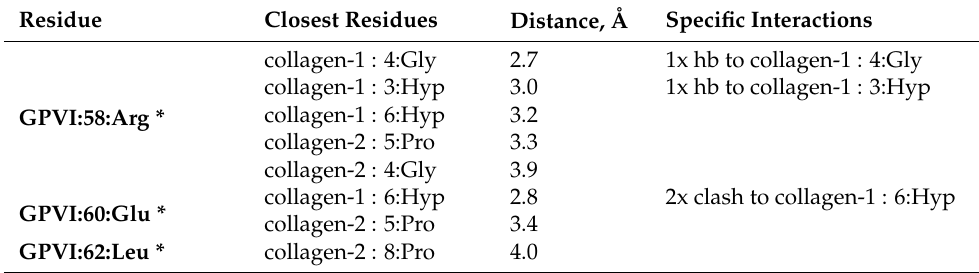
Figure 2. Binding mode of collagen with GPVI. ( A ) The docking simulation of collagen and GPVI dimer. The interaction between collagen and the blocking peptide residues in GPVI. The complex structure (PDB code: 5OU8) of GPVI and collagen-peptide was retrieved from the protein structure databank. GPVI is shown in green; peptide residues in GPVI and collagen are shown in magenta and orange, respectively. ( B ) The zoomed-in interaction between collagen and peptide residues in GPVI. The interaction residues are depicted as sticks. Red dash lines indicate hydrogen bonds between residues. Table 1. Binding mode of collagen with GPVI. * Symbol depicts residues which are in the peptide (CQGPPGVDLYRLEKL). The closest distances are